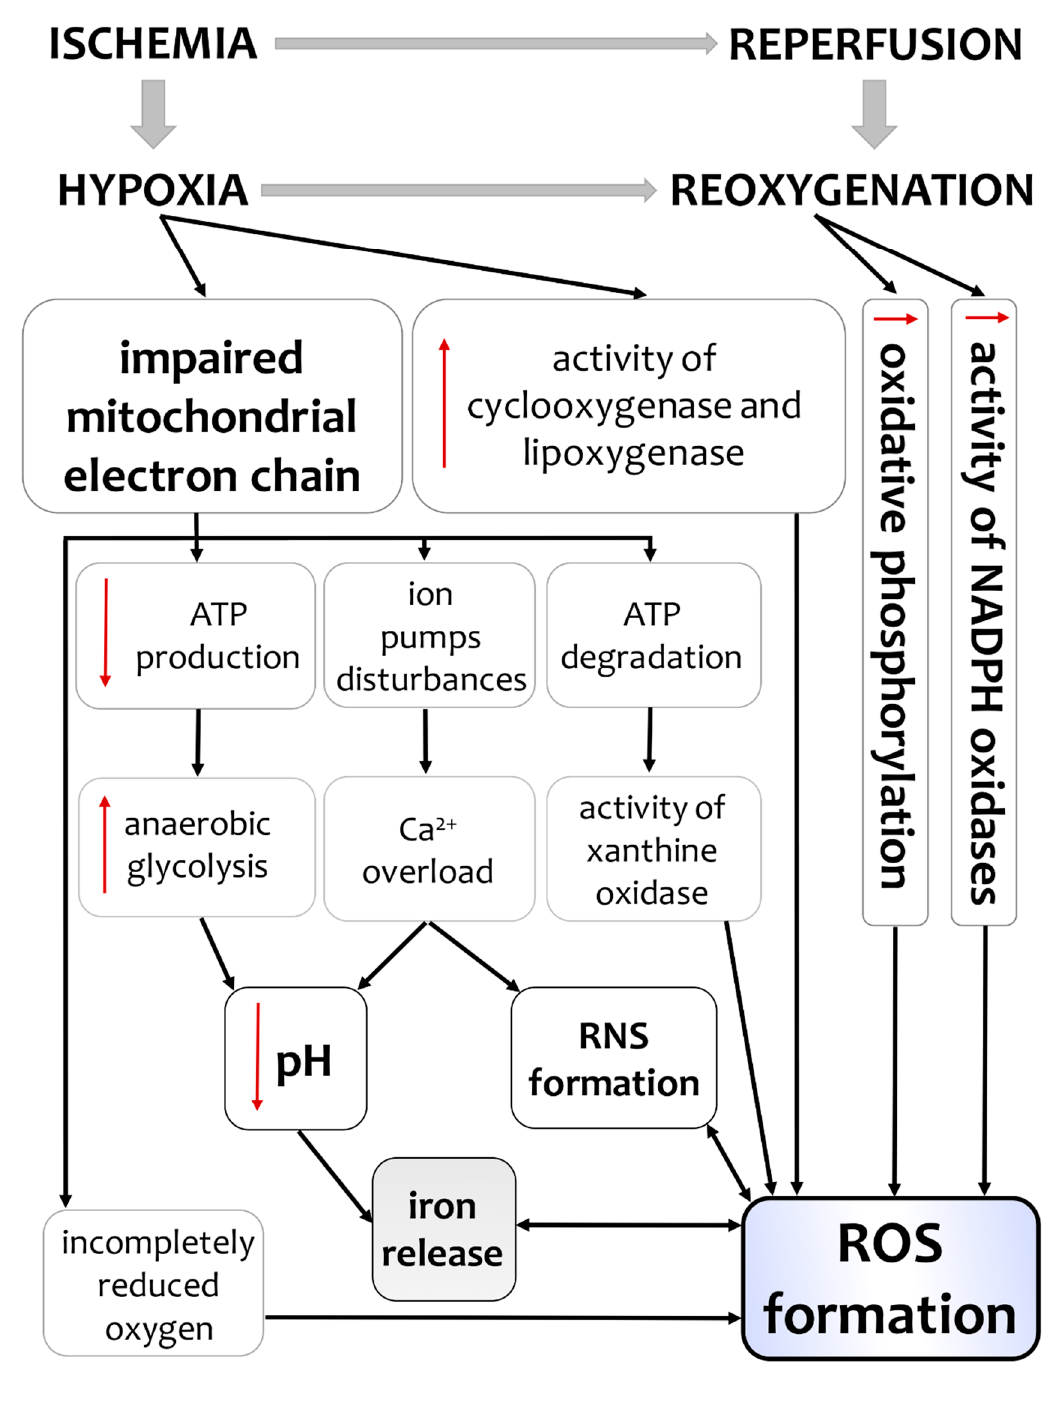
Figure 1. Mechanisms of ROS and RNS formation after hypoxia/ischemia (H/I) insult followed by reoxygenation/reperfusion. Abbreviations: ATP—adenosine triphosphate, NADPH—reduced nicotinamide adenine dinucleotide phosphate, ROS—reactive oxygen species, RNS—reactive nitrogen species.